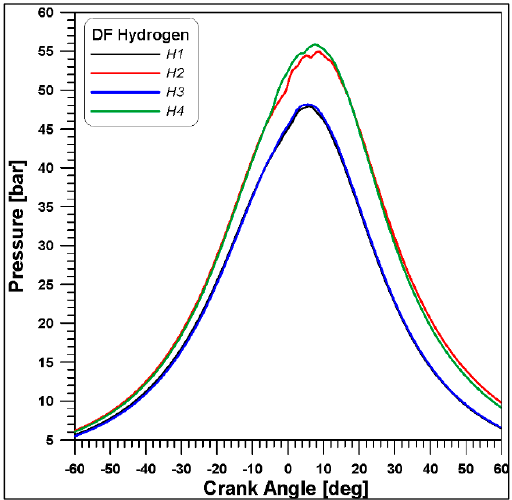
Figure 2. Experimental in-cylinder pressure. Cases with hydrogen.